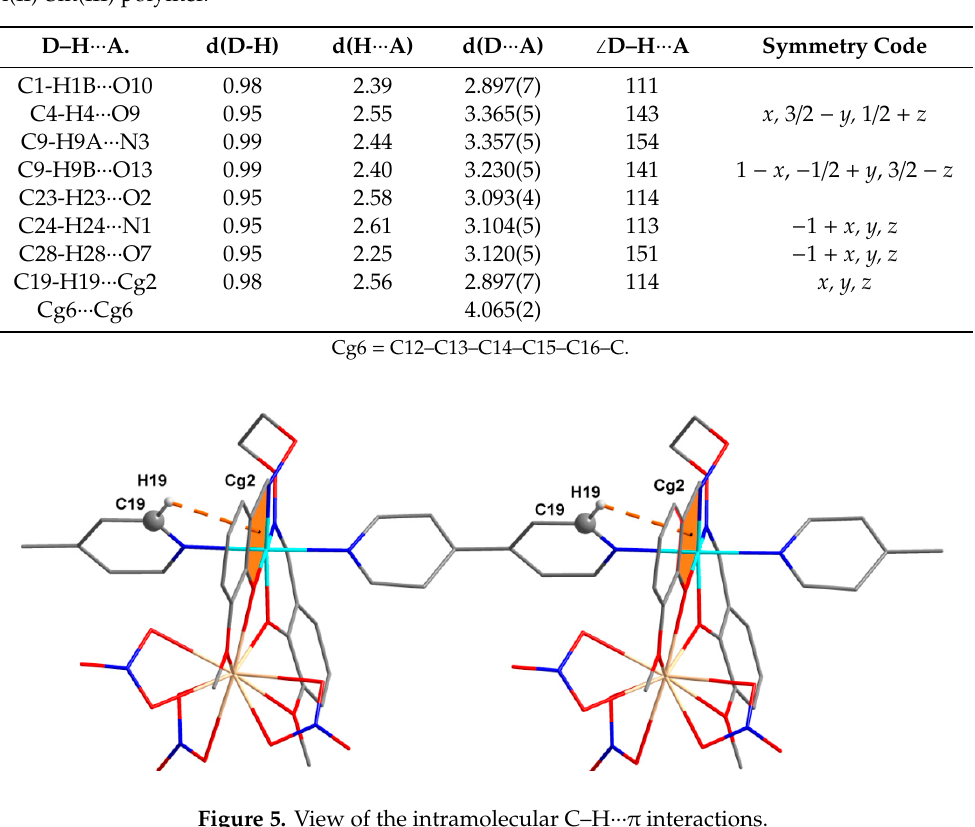
Figure 6. View of one-dimensional chain-like structure of the title polymer. The